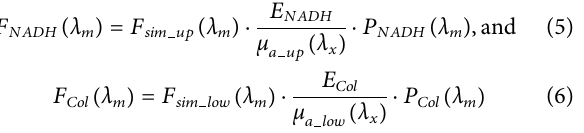
Frontiers in Physics |